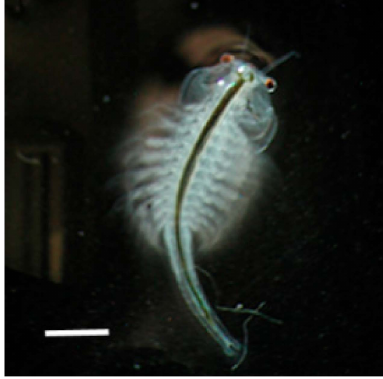
Figure 3. Optical microscopy image of Artemia sp. adult. Bar: 1